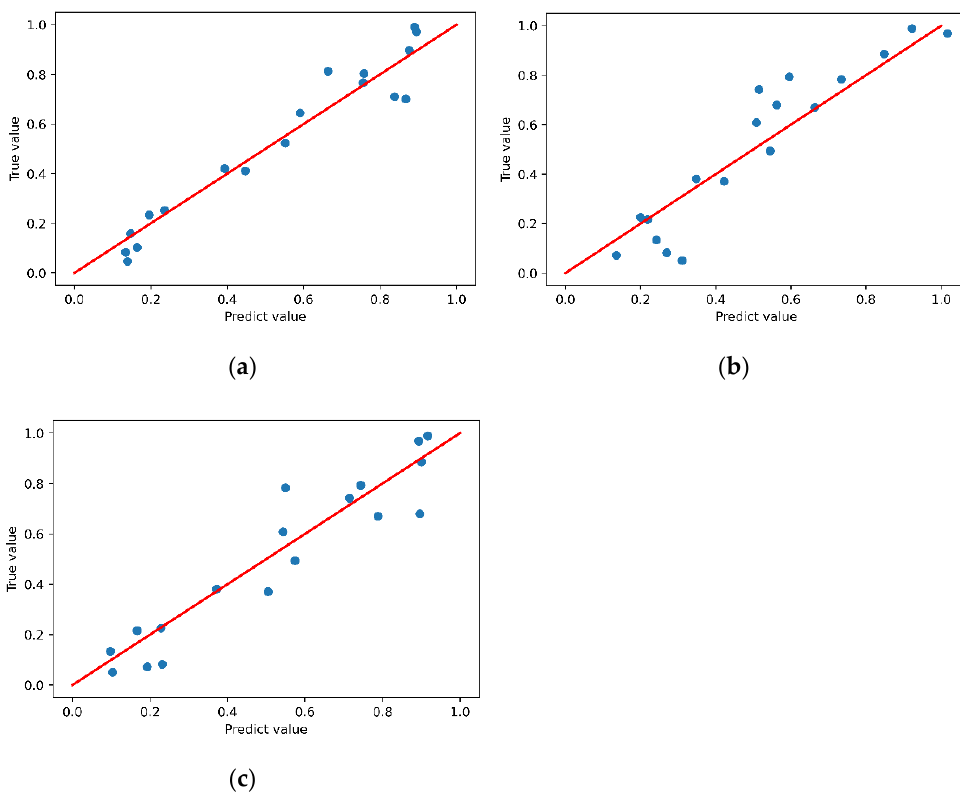
( b ) Figure 11. Prediction results obtained on the training set. ( a ) Vision Transformer. ( b ) Densenet121. The prediction results obtained using the validation set are shown in Figure 12. The